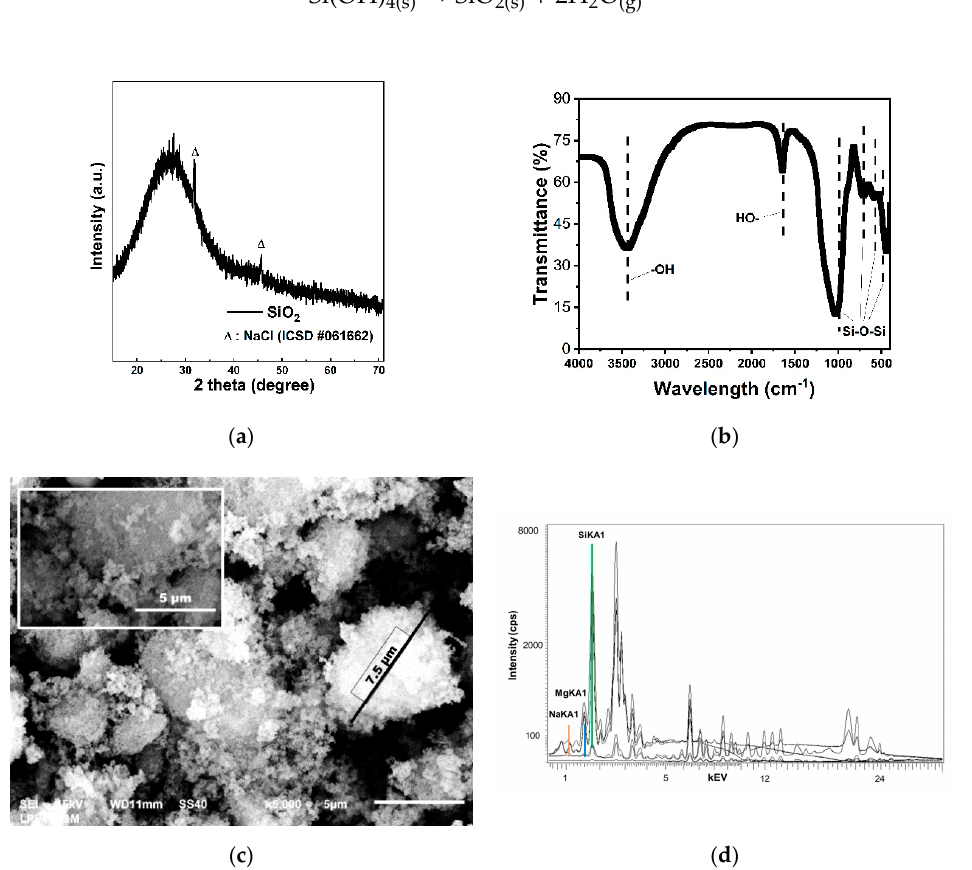
Figure 2. Coal fly ash-derived SiO 2 characterization by ( a ) XRD, ( b ) FTIR, ( c ) SEM, and ( d ) XRF. The as-obtained SiO 2 powder was directly applied as anode in a NCA/SiO 2 battery. Figure 3 shows the electrochemical performance of the cell. The theoretical capacity of SiO 2 is adapted from a